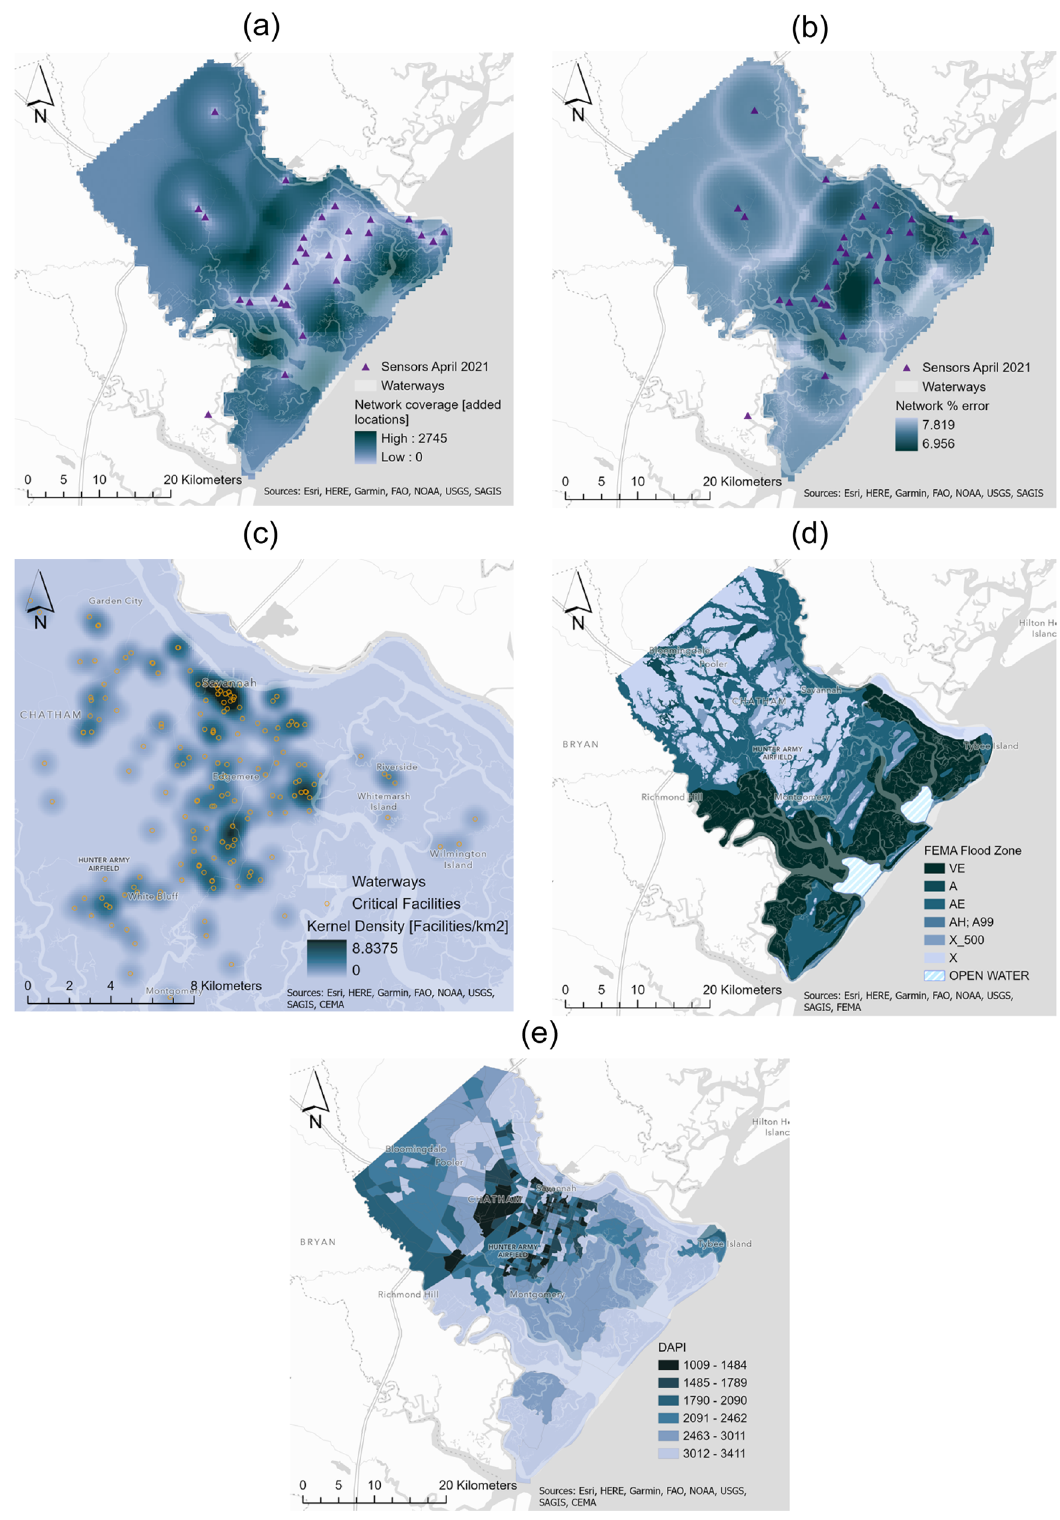
Fig. 1 Sensor network parameters. a Network coverage is measured by the number of added locations covered by placing the sensor in the new location. b Network uncertainty measured by the mean error in the inundation map. c Critical infrastructure facilities density as measured using a kernel density. d FEMA fl ood zones indicating the likelihood of fl ooding. e Damage Assessment Priority Index (DAPI) ranking social vulnerable (lowest ranking number) to least vulnerable (highest vulnerable areas in the county (Fig. 1e). Final DAPI values range ranking number), and the DAPI is composed of the sum of these from 1009 to 3411. A lower DAPI ranking value indicates higher three rankings. The DAPI is used here in collaboration with vulnerability and higher priority for locating new sensors, shown CEMA to prioritize locations of new sensors near more as the darkest blue locations in the fi gure.